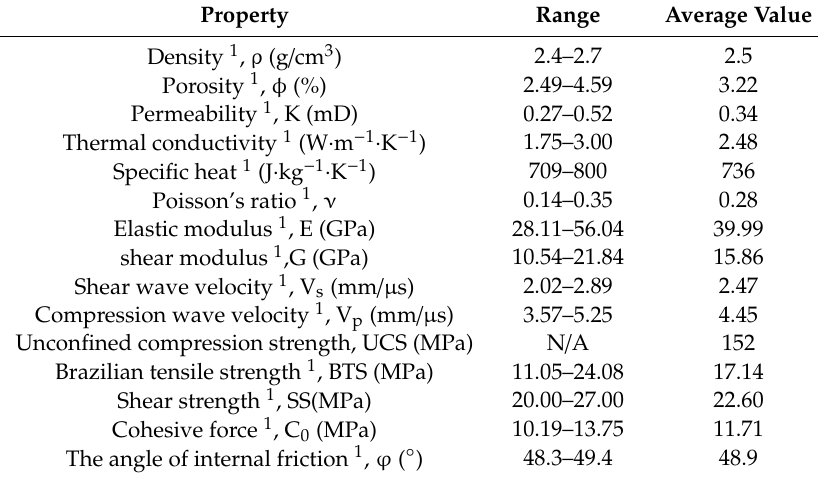
Figure 2. ( a ) A complete outcrop rock sample and ( b ) the outcrop rock sample were cut into 300 × 300 × 300 mm cubes. Table 1. Physical properties of rock samples.